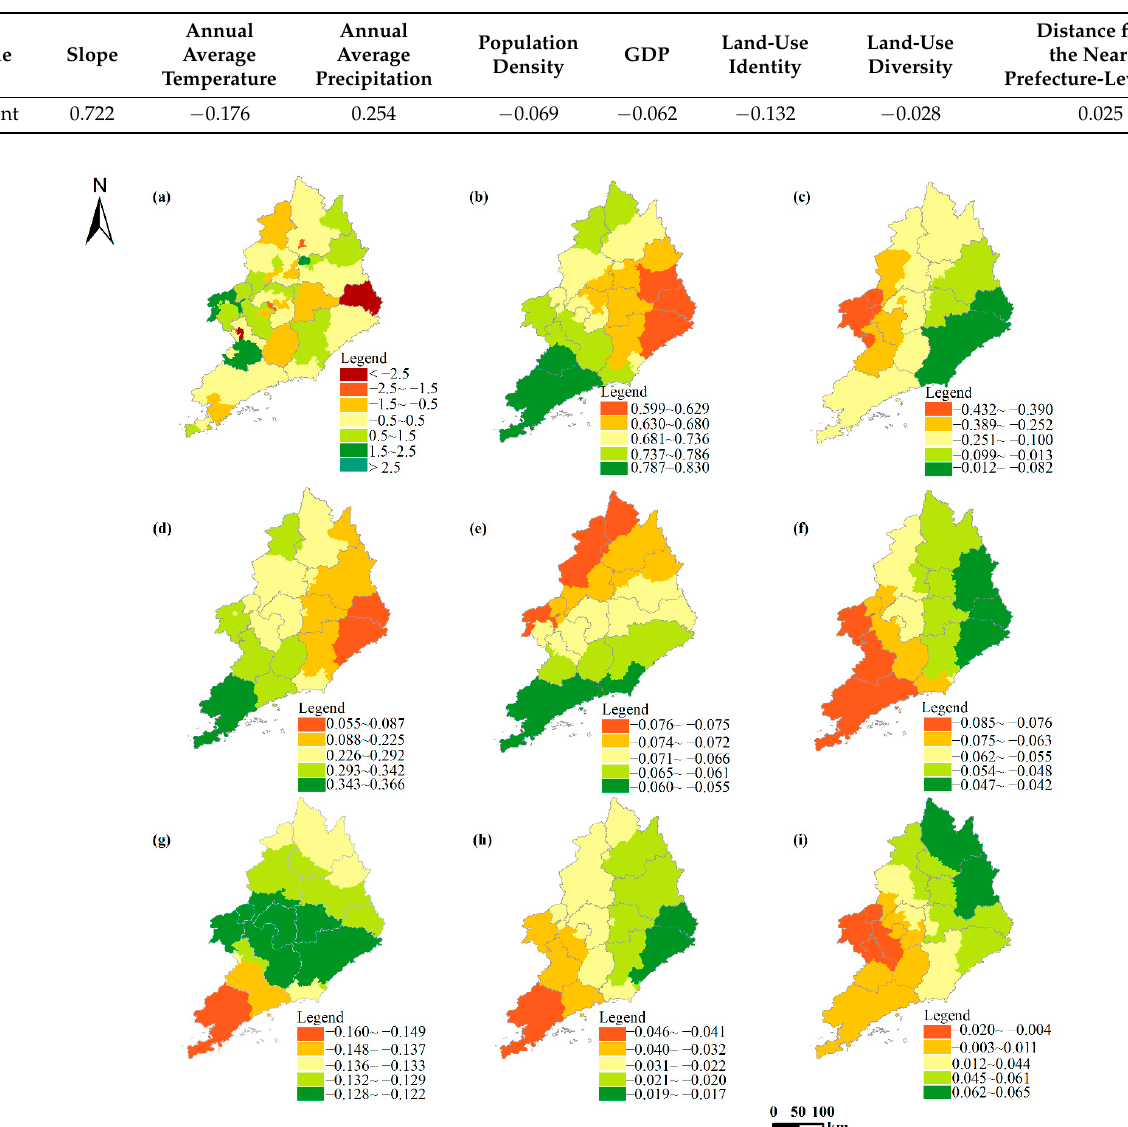
Table 9. Statistical description of MGWR coefficient means.